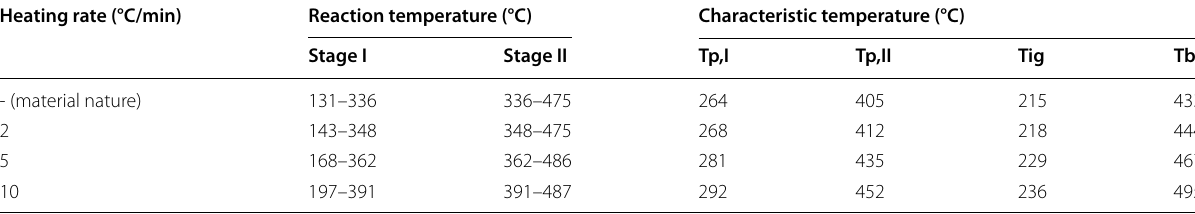
Table 2 Reaction temperatures and characteristic temperatures of the combustion reaction under different heating rates Heating rate (°C/min) Reaction temperature (°C) Characteristic temperature (°C) Stage I Stage